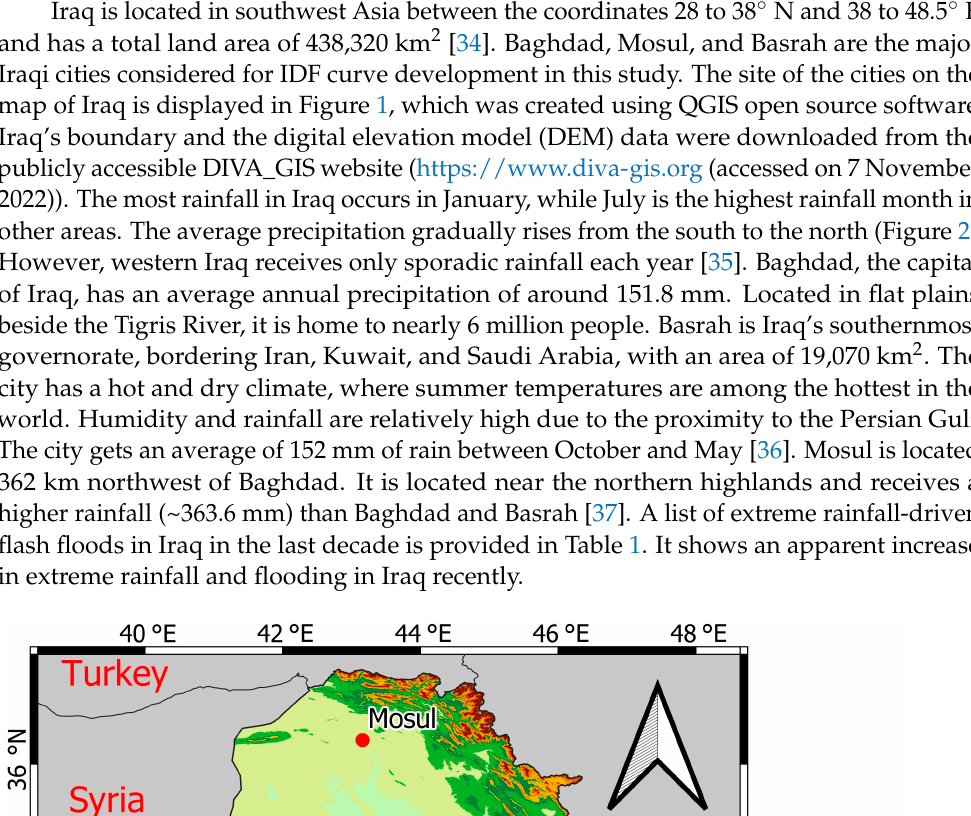
Figure 2. Annual mean rainfall in mm. 2.2. Dataset This study also employed three types of remotely sensed precipitation data. Table 2 details the remote sensing precipitation datasets. IMERG integrates precipitation data us- ing the Global Precipitation Measurement (GPM) satellites. The precipitation data in all the satellite products used in this study was retrieved using a combination of multiple